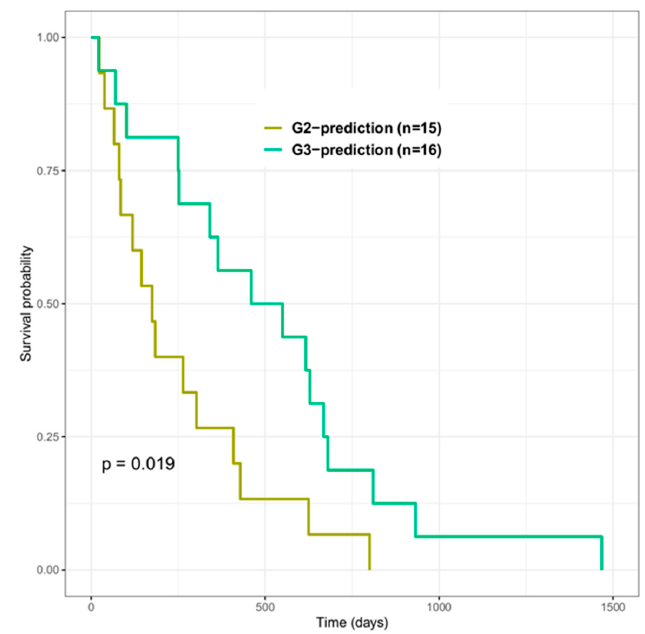
Figure 4. Effectiveness of models for T1C with G2- and G3-prediction groups. G2- and G3-prediction groups were determined using independent testing data ( n = 84) fed to the T1C radiomics models. The log-rank test for the survival curves between the two groups indicated statistical significance.